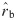
Indirect range restriction (IRR): Effects of a weak, moderate, and strong predictive validity on the root mean square error (RMSE) of the estimates of the predictive validity (r^b and r^pb).r^b is the estimate of the biserial correlation coefficient for an artificially dichotomous criterion variable, and r^pb is the estimate of the point-biserial correlation coefficient for a naturally dichotomous criterion variable.